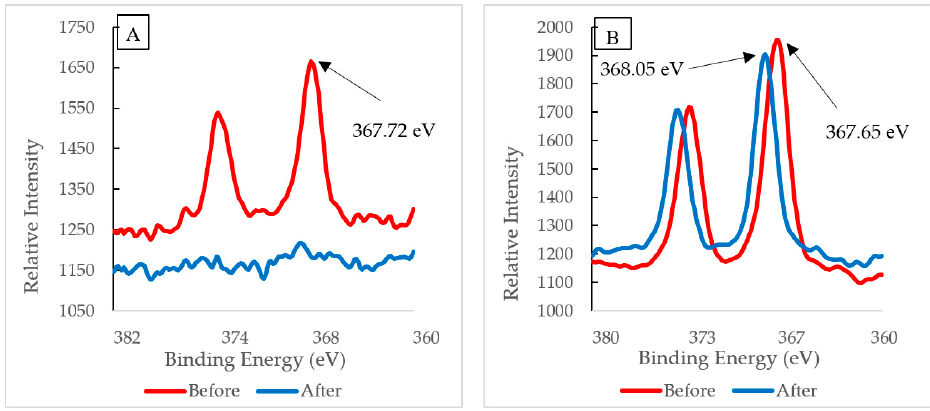
Figure 6. Before and after filtration XPS Spectra of ( A ) PVA-Ag and ( B ) PVA-UV.